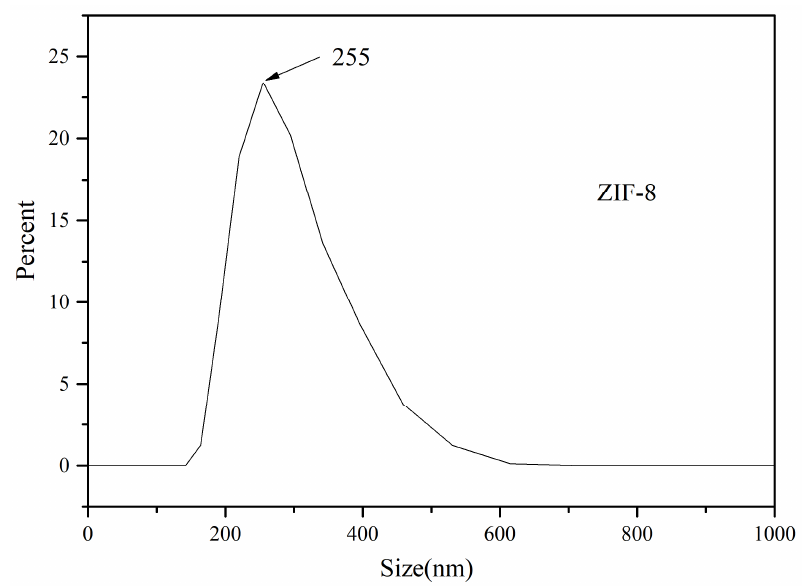
Figure 3. Particle size distribution of ZIF-8 .